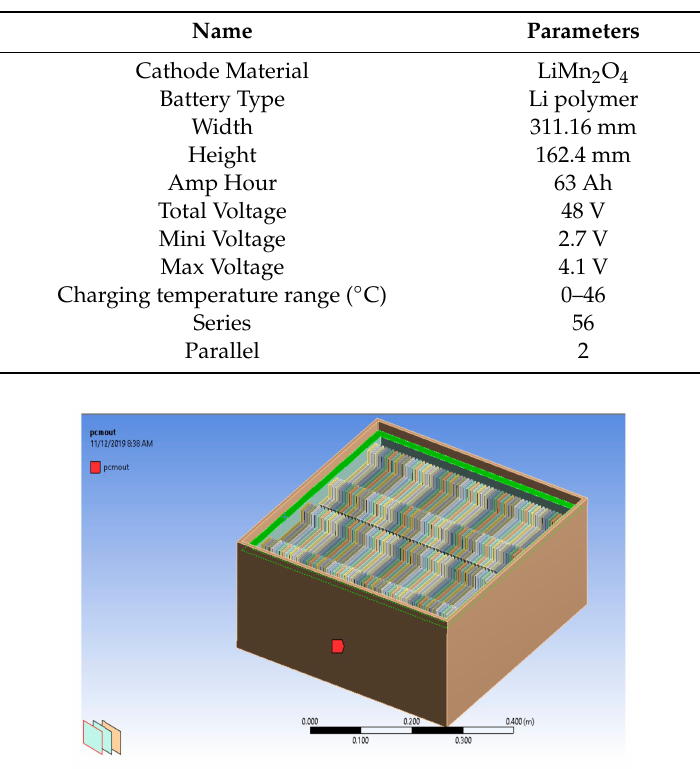
Table 2. Specifications of the 6-kW Li polymer battery module.